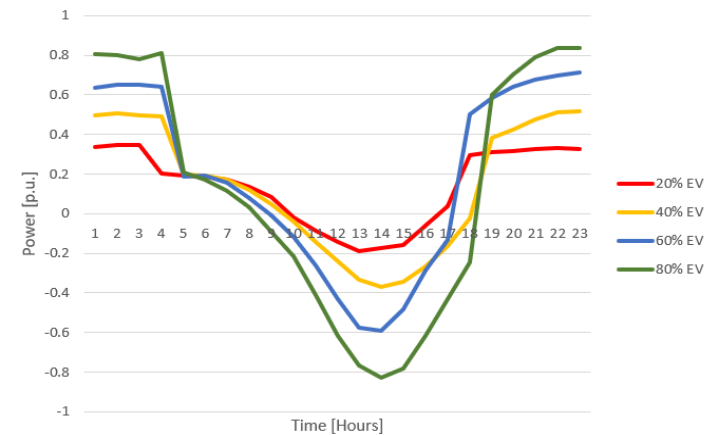
Figure 6. Battery charging and discharging process.